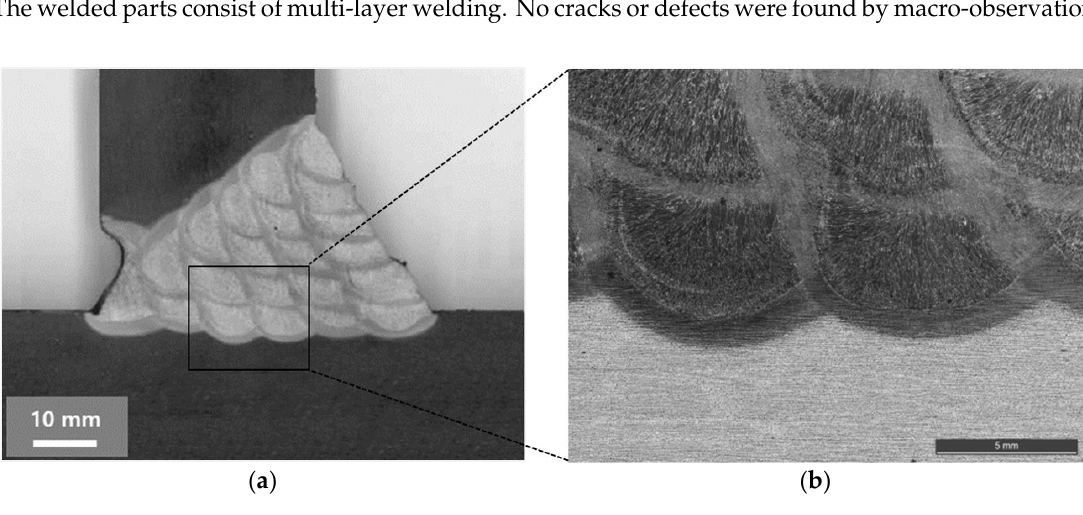
Figure 9. ( a ) Macrography of the welded T-joint of the 30 mm thick plate, and ( b ) inset—magnification around the fusion line of the welded T-joint.